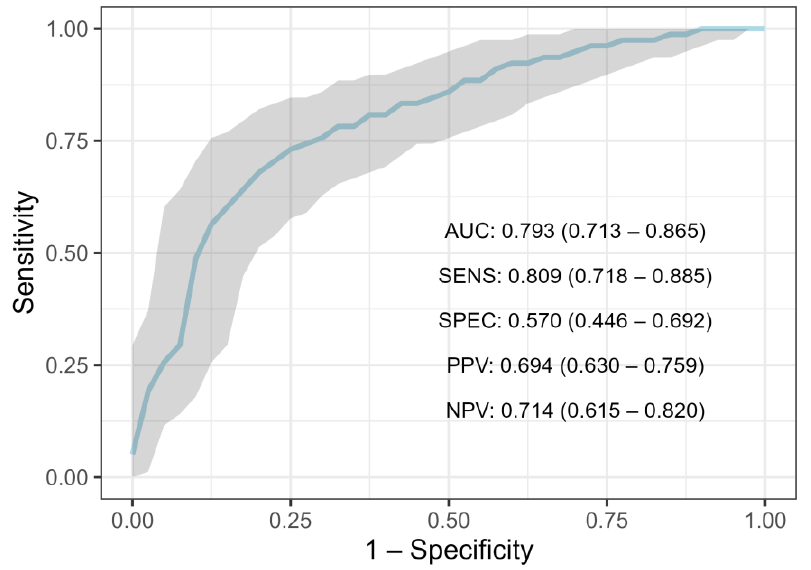
Figure 2. ROC-curve for Random Forest trained on NST-criteria group. (ROC — receiver operating characteristic curve, AUC — area under the curve, SENS — sensitivity, SPEC — specificity, PPV — positive predictive value, NPV — negative predictive value).